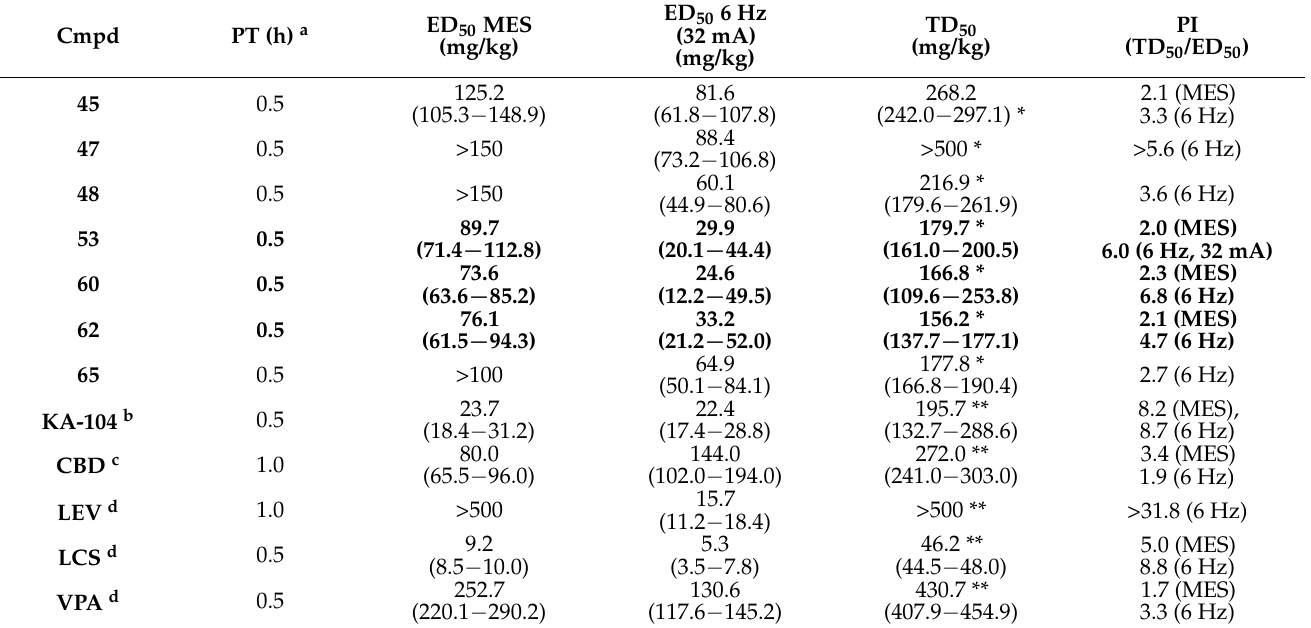
Table 2. The ED 50 , TD 50 , and PI values in mice after i.p. dosing of the newly obtained compounds and reference ASDs in